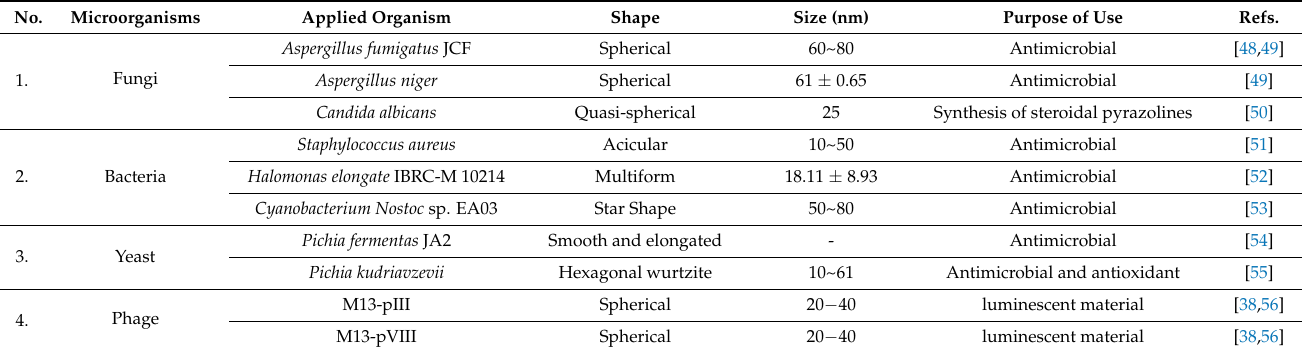
Table 1. Microorganisms-mediated synthesis of ZnO-NPs.